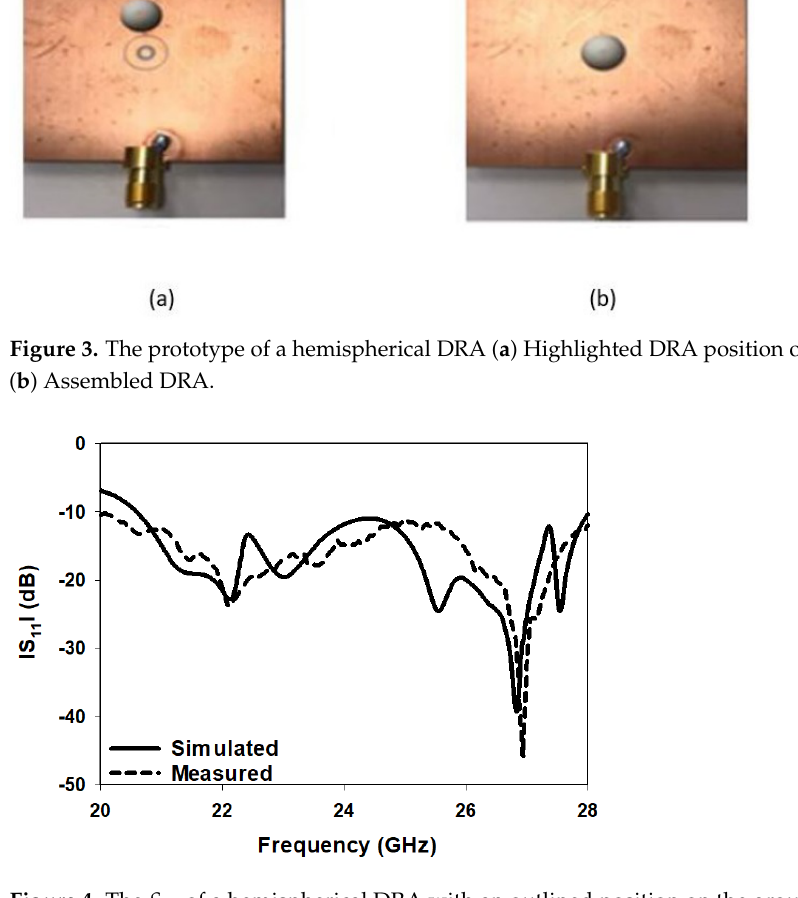
Figure 4. The S 11 of a hemispherical DRA with an outlined position on the ground plane.